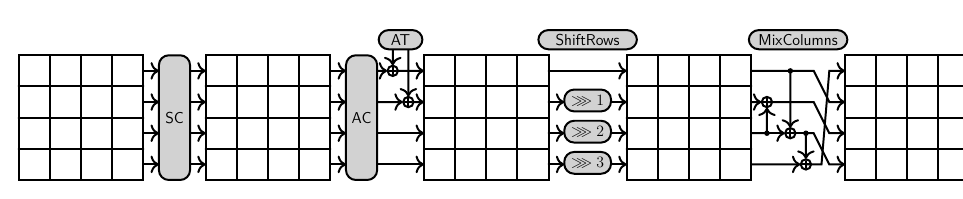
Figure 4: Skinny round function.